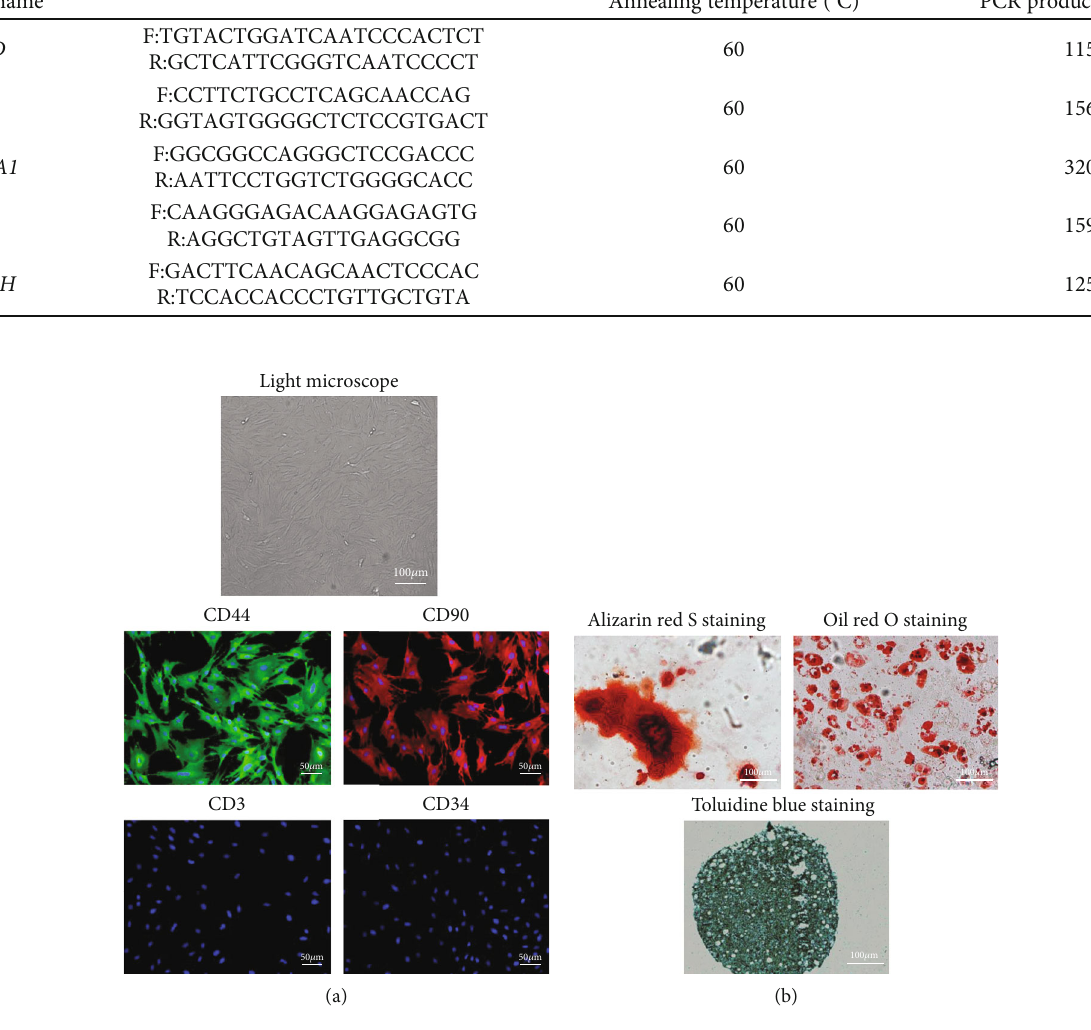
Figure 1: Cell morphology of tendon stem and progenitor cells on tissue culture plates under light microscope and immuno fl uorescence staining of CD44, CD90, CD3, and CD34 markers (a). Alizarin red S, oil red O staining, and toluidine blue staining after induction of osteogenesis, adipogenesis, and chondrogenesis